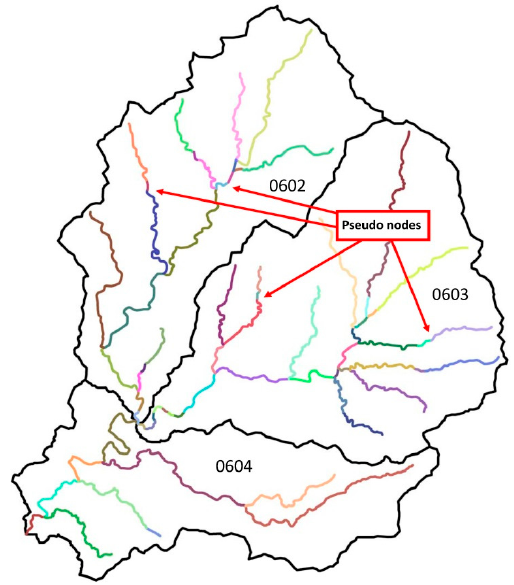
Figure 3. Individual NHDPlus V2 stream segments are identified by color. Example pseudo nodes are identified by red arrows. This figure depicts U.S. Geological Survey (USGS) HUC8 12090107, and the last four digits of each HUC-12 code are shown. A total of 73 separate stream segments are depicted.